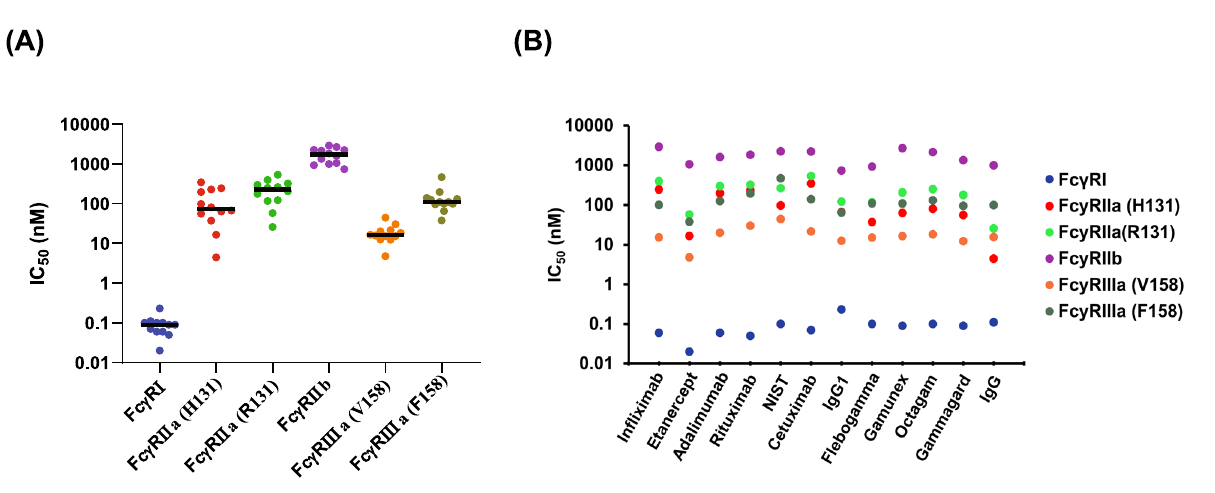
Figure 7. Dose dependent inhibition curves generated with six different NanoBiT FcγR assays. Four commercial IVIg preparation were tested. Inhibition curve for IgG, generated earlier (Fig. 3), is also included for comparison. Data represent the mean ± standard error of triplicate readings. IC 50 (nM) values calculated from the inhibition curves are shown in the Table. IC 50 values are in nM. *For FcγRIIb, IC 50 values are intended only for qualitative purposes as mentioned in the text.